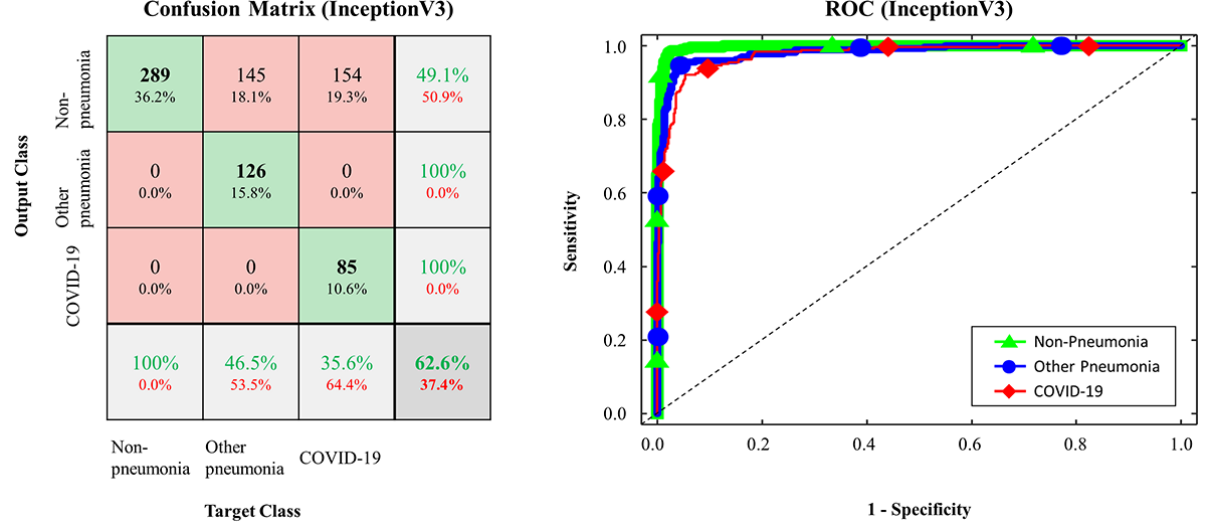
Figure 5. Confusion matrix and ROC curve in FCONet using Inception-v3; COVID-19: coronavirus disease; ROC: receiver operating